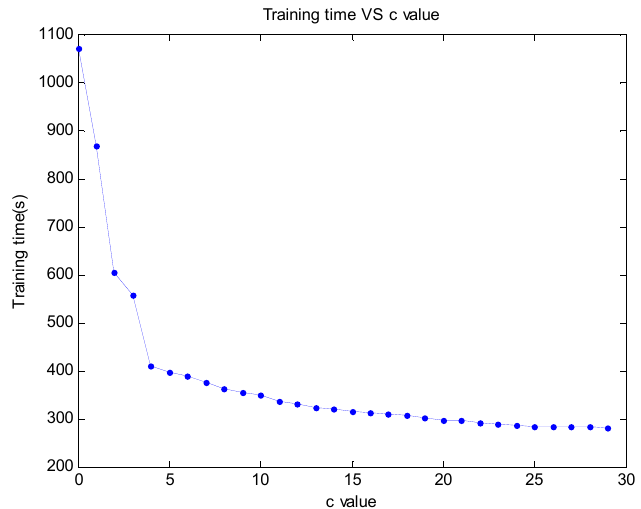
Figure 9. Result of exploratory experiments on the weakening fusion ratio.